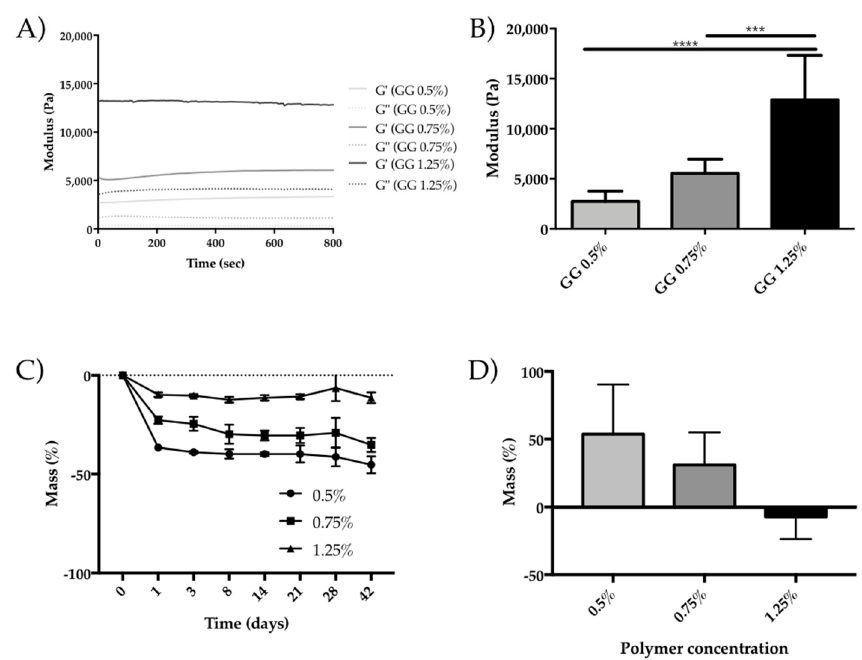
Figure 2. Physic-chemical and mechanical properties of gellan gum (GG) hydrogels. ( A ) Representative dynamic time sweep of storage (G ′ ) and loss (G ′′ ) moduli of GG hydrogels using strain of 0.5%, frequency of 10 rad/s and at 25 °C. ( B ) Plot of storage (G ′ ) and loss (G ′′ ) moduli of GG hydrogels obtained from the dynamic time sweep ( n = 5). ( C ) Mass loss profile of GG hydrogel particles along incubation with a saline solution for 42 days (six weeks, n = 5). ( D ) Plot of maximum mass value after six weeks. *** p < 0.001 and **** p < 0.0001.